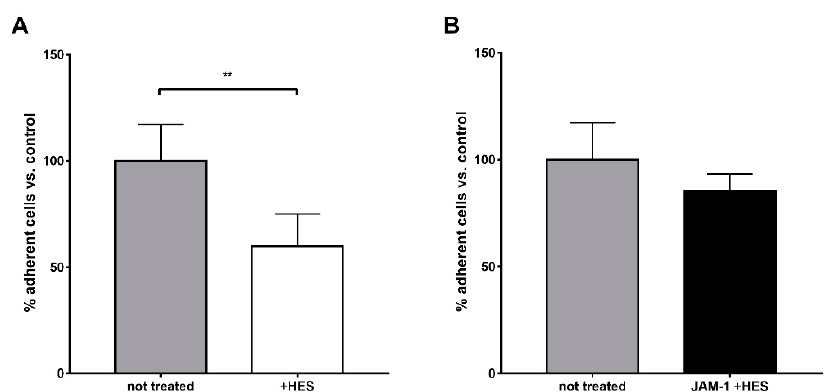
Figure 6. Static adhesion assay performed on different substrates. Cells were fluorescently labeled with calcein and then subjected to adhesion on different substrates. ( A ) When fibrinogen was used as a substrate for adhesion, HES pre-treatment strikingly decreased (almost 50%) the adhesion of cells. ( B ) The adhesion of neutrophils on JAM-1 was not impaired by HES, suggesting a Mac-1 specific effect. The presented results are the mean ± SD of four independent experiments. ** p < 0.01.